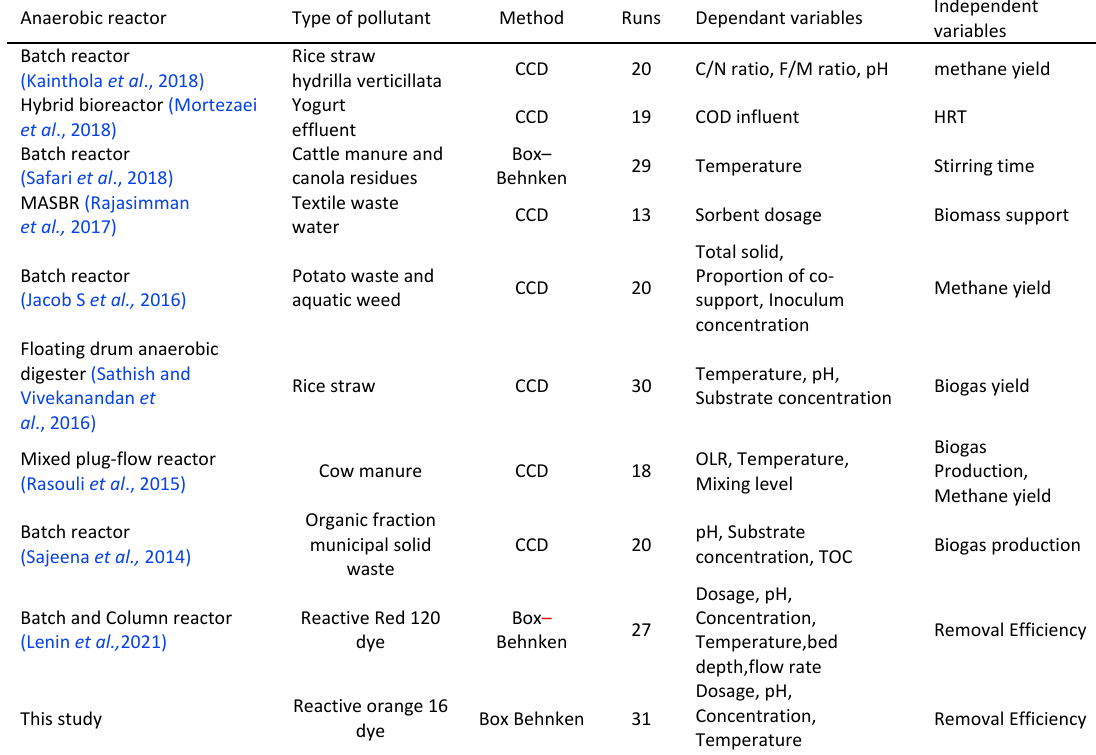
Table 5: Overview of work carried out using RSM